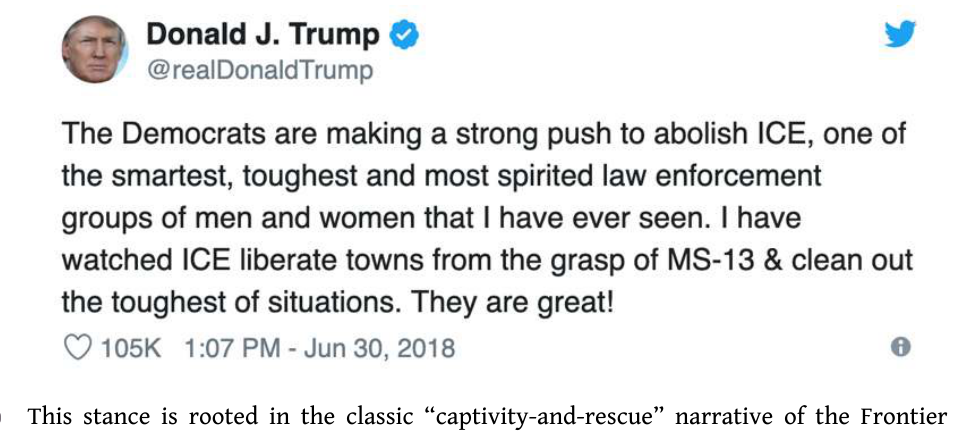
Figure 5. Tweet by Donald Trump attacking Democrats and defending ICE on June 30,